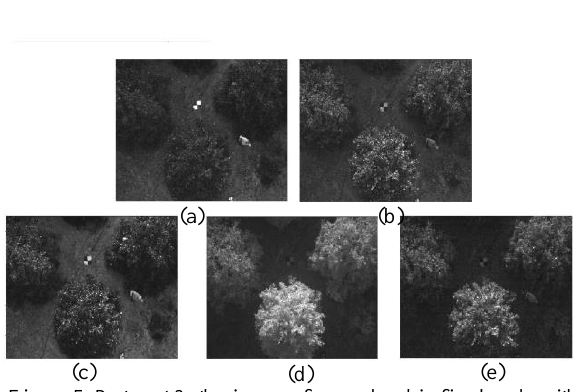
Figure 5. Data set 3: the image of an orchard in five bands with high altitudes differences, up to 6 meters: (a) red, (b) green, (c) blue, (d) NIR, (e) red-edge.